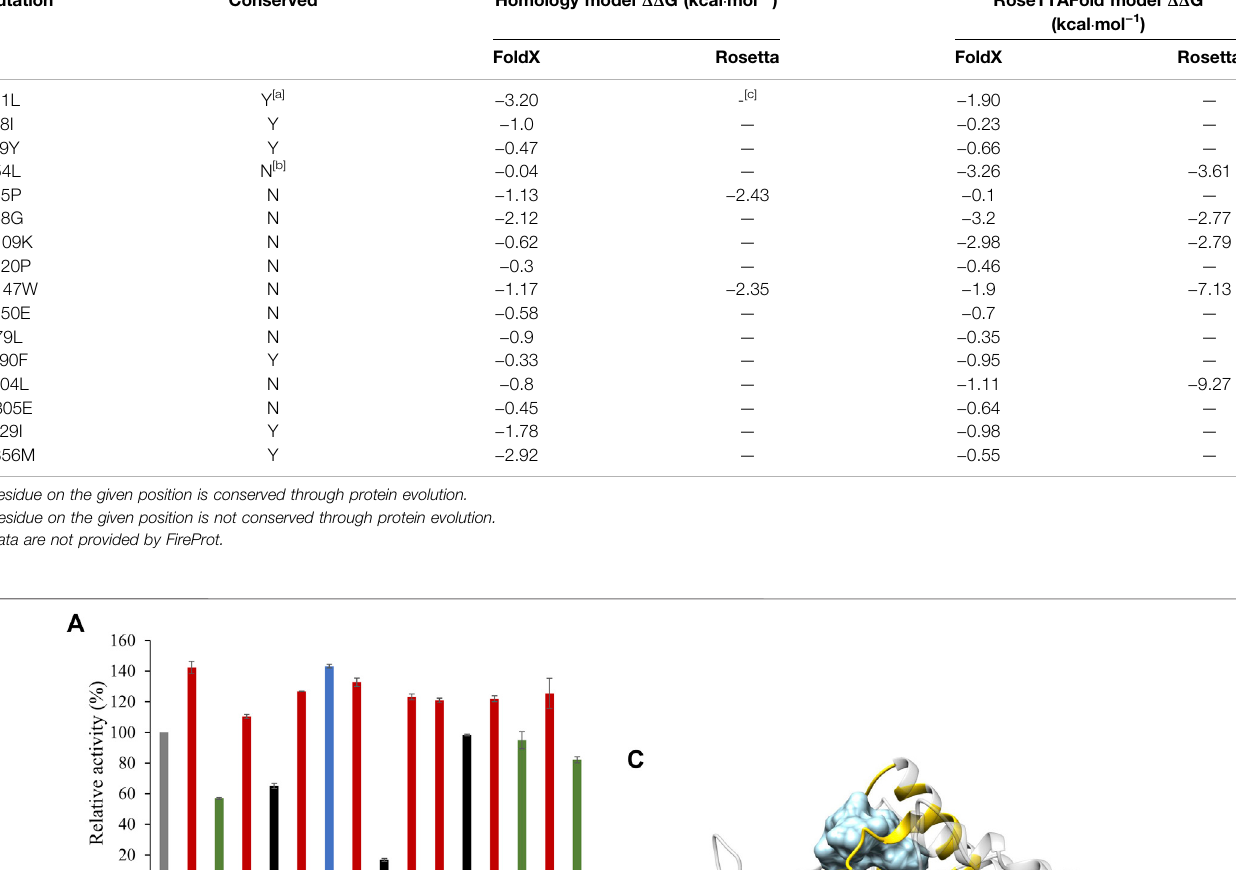
TABLE 2 | Information of the mutations selected for characterization.